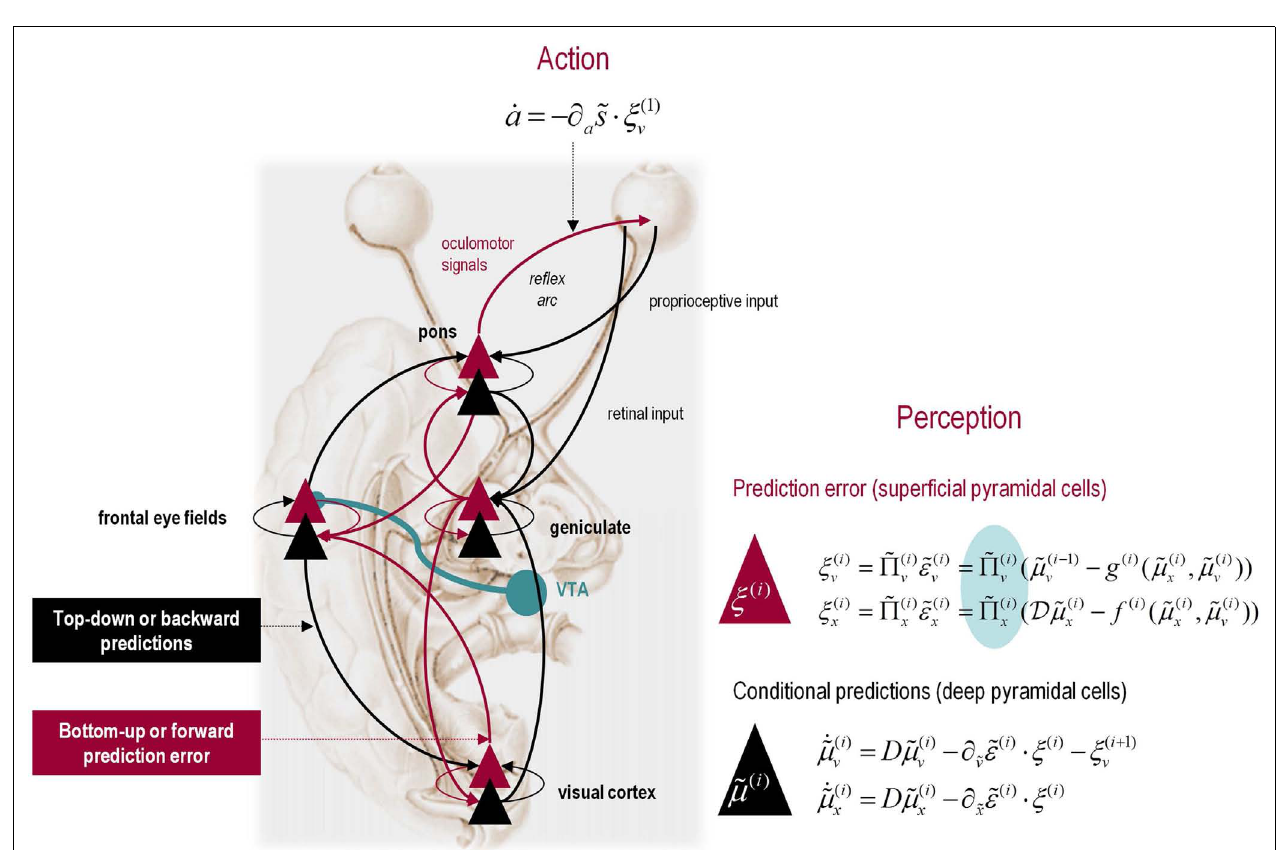
are simplified versions of Eq. 3, in which state-dependent precision has been suppressed. State units are in black and error units are in red.The cyan circle highlights where precisions enter these equations – to modulate prediction error units (superficial pyramidal cells) such that they report precision-weighted prediction errors. In this schematic, we have placed different levels of a hierarchical model within the visual-oculomotor system. Visual input arrives in an intrinsic (retinal) frame of reference that depends on the direction of gaze. Exteroceptive input is then passed to the lateral geniculate nuclei (LGN) and to higher visual and prefrontal (e.g., frontal eye fields) areas in the form of prediction errors. Crucially, proprioceptive sensations are also predicted, creating prediction errors at the level of the cranial nerve nuclei (pons).The special aspect of these proprioceptive prediction errors is that they can be resolved in one of two ways: top-down predictions can change or the errors can be resolved through classical reflex arcs – in other words, they can elicit action to change the direction of gaze and close the visual–oculomotor